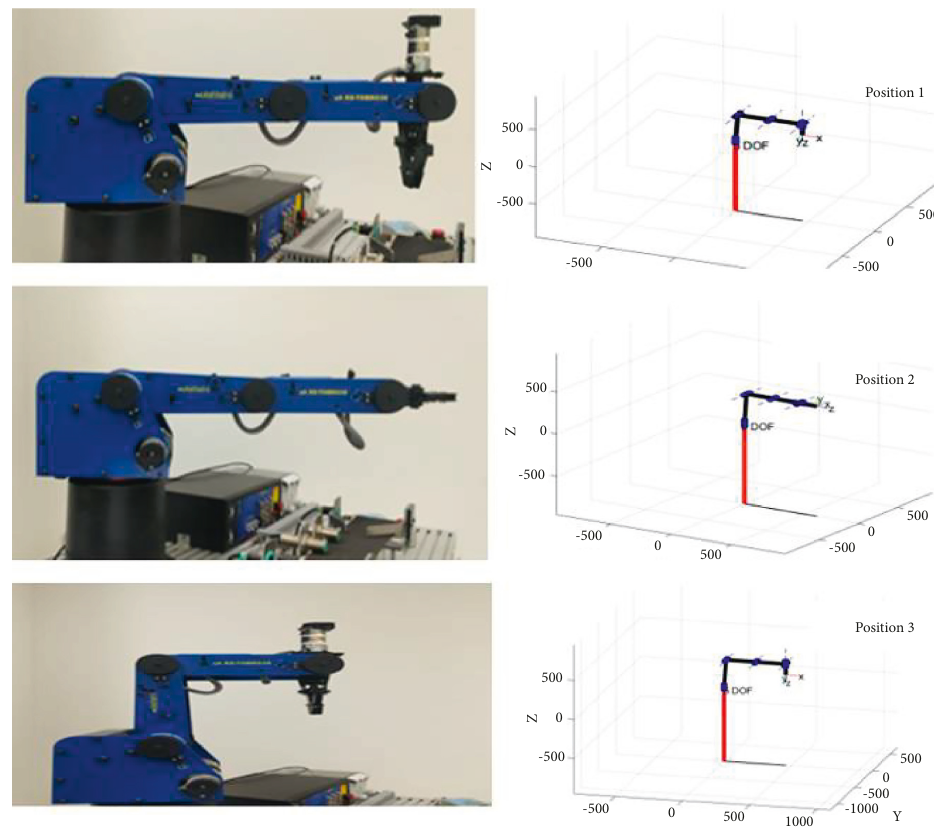
Figure 5: Mathematical model validation experiments.